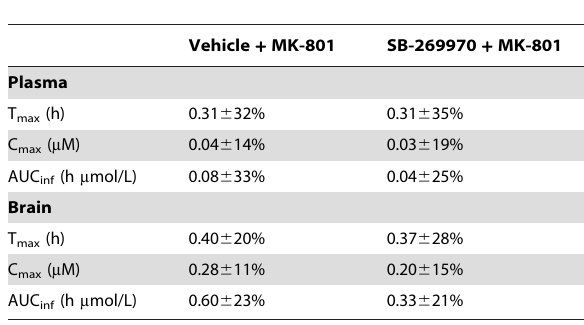
Table 2. Pharmacokinetic and blood brain barrier parameters of MK-801 (0.1 mg/kg, IP) co-administered with vehicle or with SB-269970 (10 mg/kg,